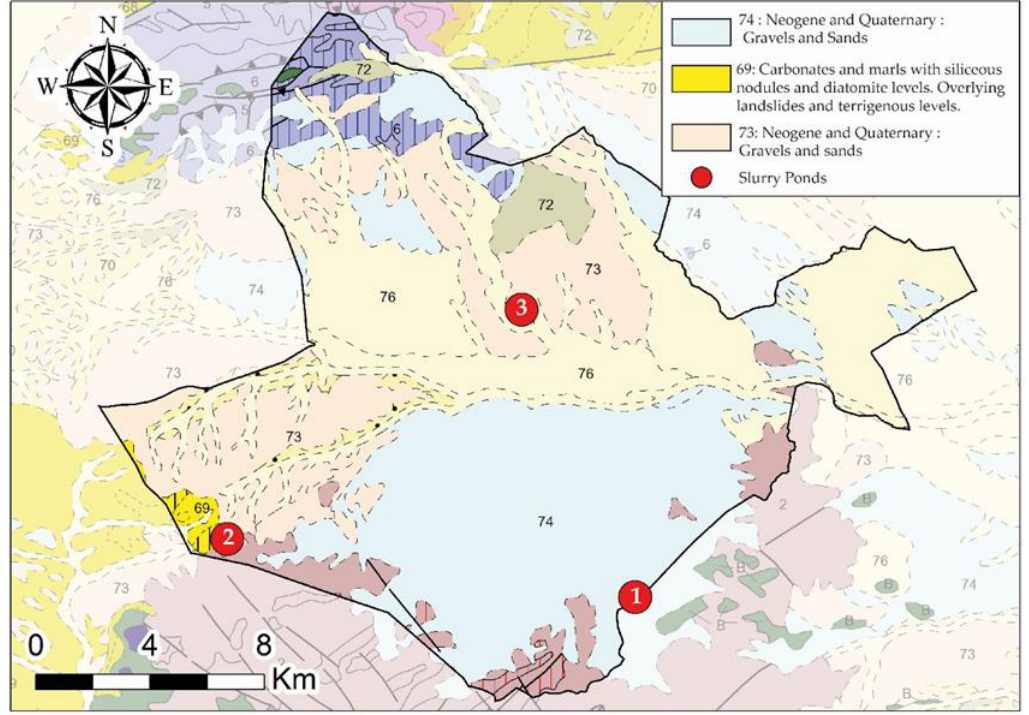
Figure 2. Geological map of the Region of Murcia (1:200,000) (Source: GEODE, Spanish Geological Survey (IGME)).